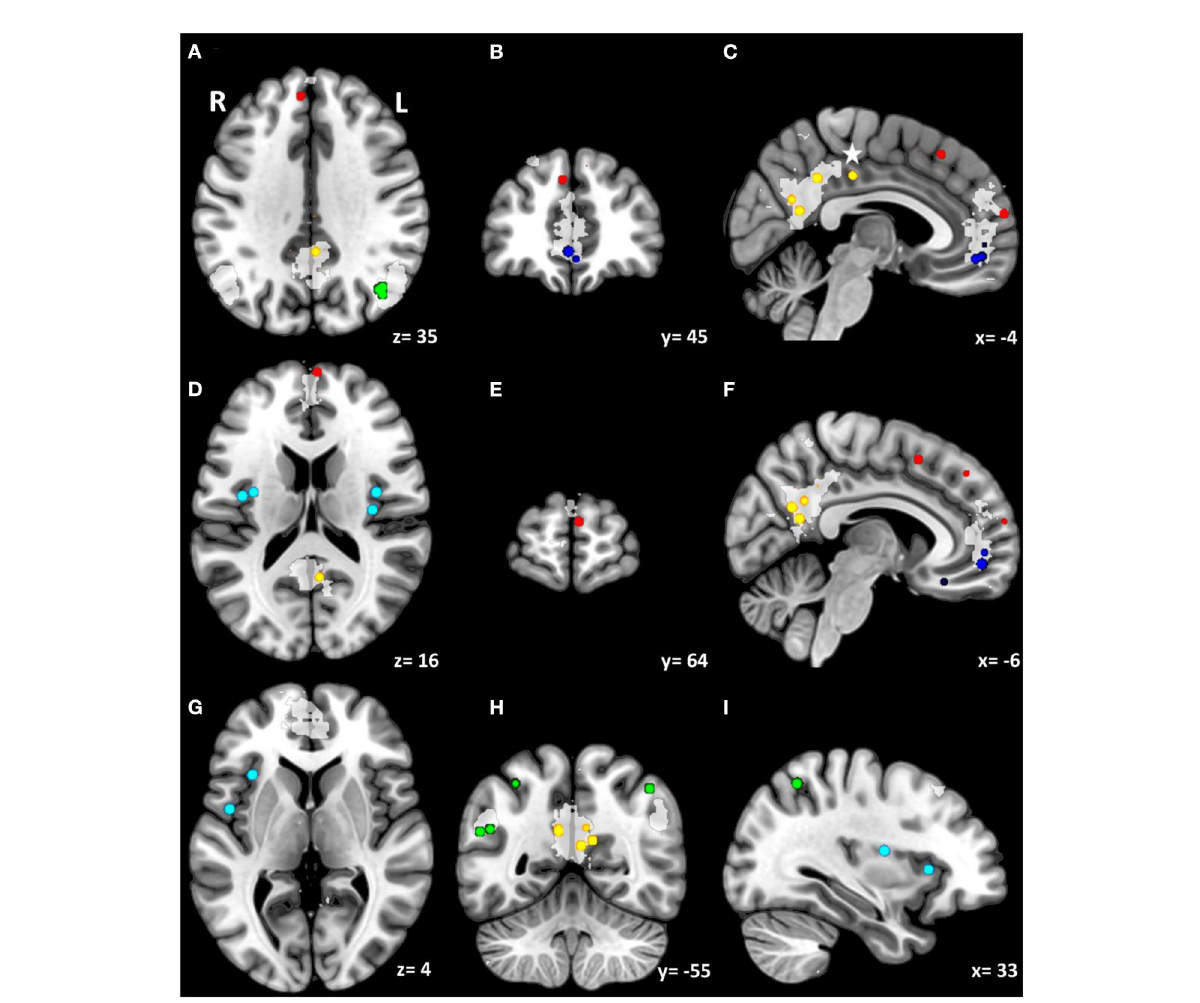
FIGURE1 Involvement of default mode network constituents as well as the insular cortex. The Figure indicates centers of gravity of cortical involvement observed in selected neuroimaging studies detailed in Supplementary Table S3, integrated into the standard MNI 152 template. For according MNI coordinates see Supplementary Table S4. Enclosed is furthermore an automated topic-based meta-analysis using the term “DMN” in article abstracts provided by https://neurosynth.org/analyses/terms/dmn/ for comparison purposes. The light-gray areas superposed on the anatomical slices delineate zones preferentially associated with the term in 366 neuroimaging studies with an expected FDR < 0.01. The red and dark blue spheres indicate the involvement of dorsal and ventral mPFC, and the yellow spheres indicate PCC involvement. (A–F) Self-specifying processes involve the dorsal mPFC whereas self-relational processes involve ventral mPFC, together with pre- and subgenual ACC, as well as PCC and retrosplenial cortex. Please note: Involvement of mPFC at the level of superior frontal gyrus is predominant in subjects of no meditation experience suggesting voluntary effort during a task. (C,F) The dorsal area of the PCC, marked by a star, may be a separate compartment: an interface between the resting state network and the network regulating cognitive control (Leech et al., 2011). Ad insular cortex (light blue): Proximal insular cortex is a primary interoceptive center with distinct homeostatic functions (D,G,I) , whereas dorsal anterior insular cortex has been shown to support explicit interoceptive attention (I) (Wang et al., 2019). (A,H,I) IPL (green spheres) at its posterior part (angular gyrus) is related to the DMN, whereas at its anterior part (supramarginal gyrus) to the